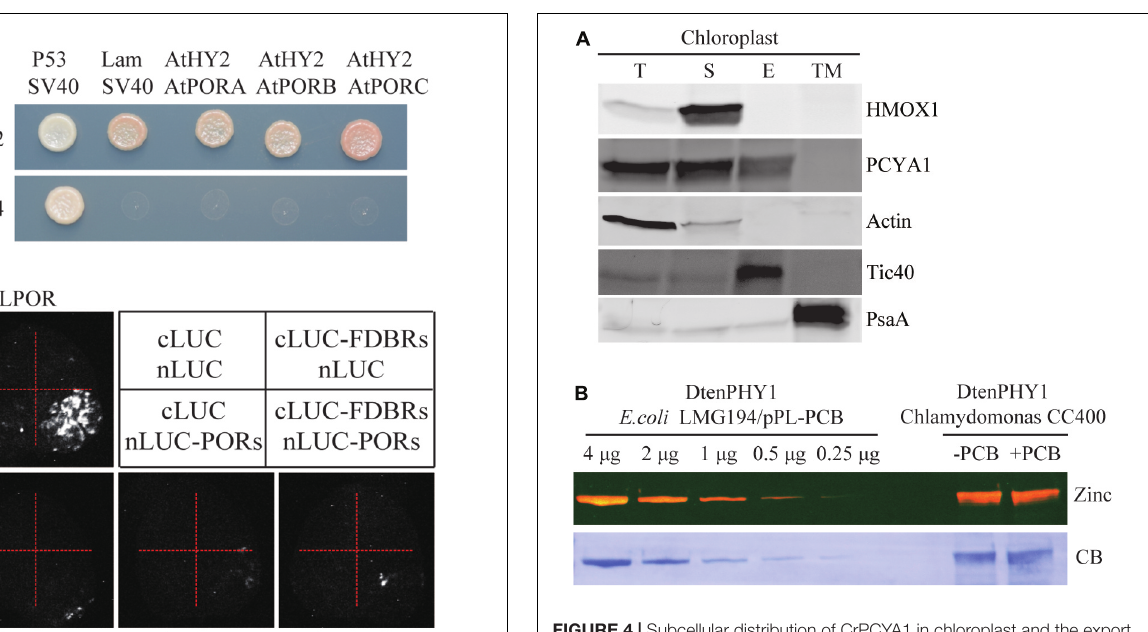
FIGURE 4 | Subcellular distribution of CrPCYA1 in chloroplast and the export of phycocyanobilin to cytosol. (A) Biochemical fractionation of chloroplast components. Antibodies against compartmental marker proteins distributed in different chloroplast fractions were employed to distinguish the presence of CrPCYA1 via immunoblot analysis of total proteins (T), soluble fraction (S), envelope membrane (E) and thylakoid membrane (TM) from isolated chloroplast. Tic40, chloroplast envelope marker; PsaA, thylakoid membrane marker. (B) Zinc-dependent fluorescence assay. Photosensory core module (PCM) region of the prasinophyte algal DtenPHY1 purified from Chlamydomonas CC400 covalently binds phycocyanobilin (PCB). Upper panel, zinc blot; lower panel, Coomassie blue stain (CB). The two-fold serial dilutions of E. coli LMG194/pPL-PCB expressed and purified DtenPHY1 were used as positive controls. –PCB, without addition of PCB; +PCB, assembly with PCB in vitro